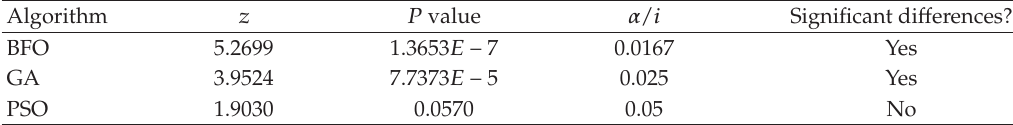
Table 7: Results of Holm’s test with dimension of 20.